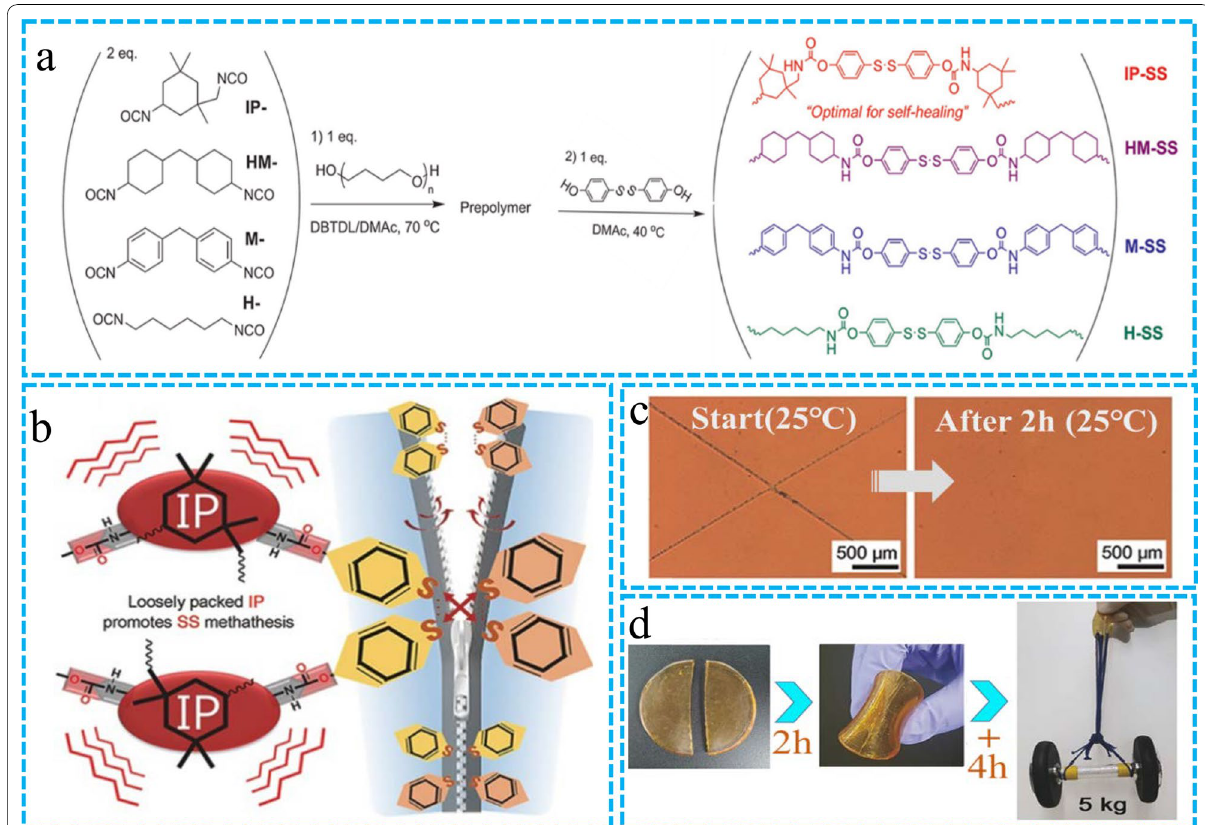
Fig. 2 a Synthetic routes and chemical structures of polyurethane containing four different diisocyanates. b Self-healable mechanism of IP–SS sample. c Optical micrographs of surface scratches of original and healed sample. d The healed IP-SS film could bend and lift up a 5 kg dumbbell. Reprinted with permission from Reference [48]. Copyright 2018, John Wiley and